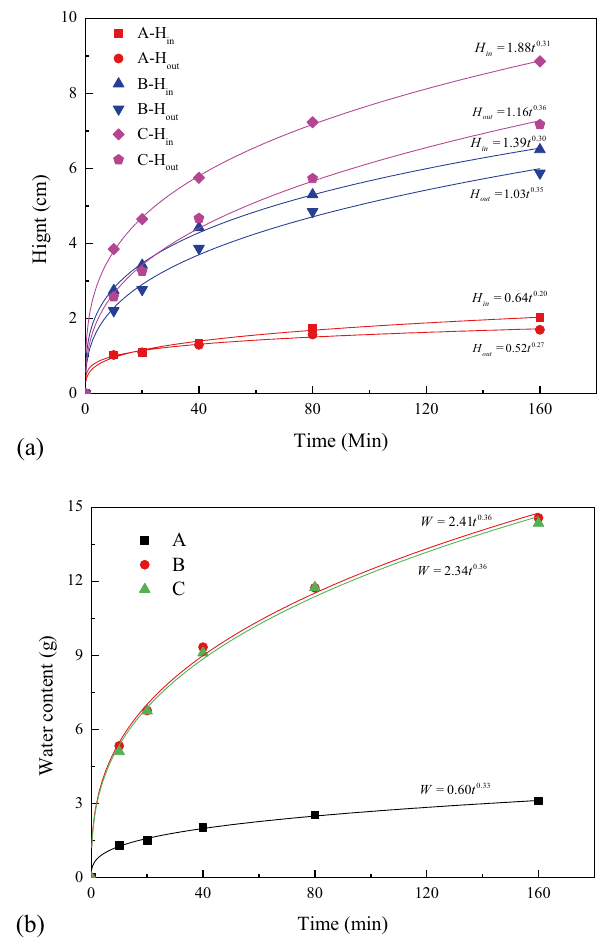
Figure 6. Evolution of capillary rise parameters in samples with different